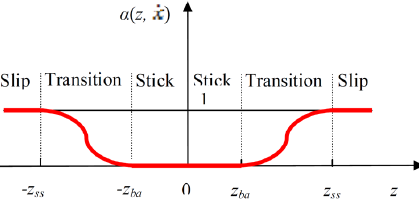
Figure 5. Dependency of α(z, ˙ x) on deformation of the asperity.